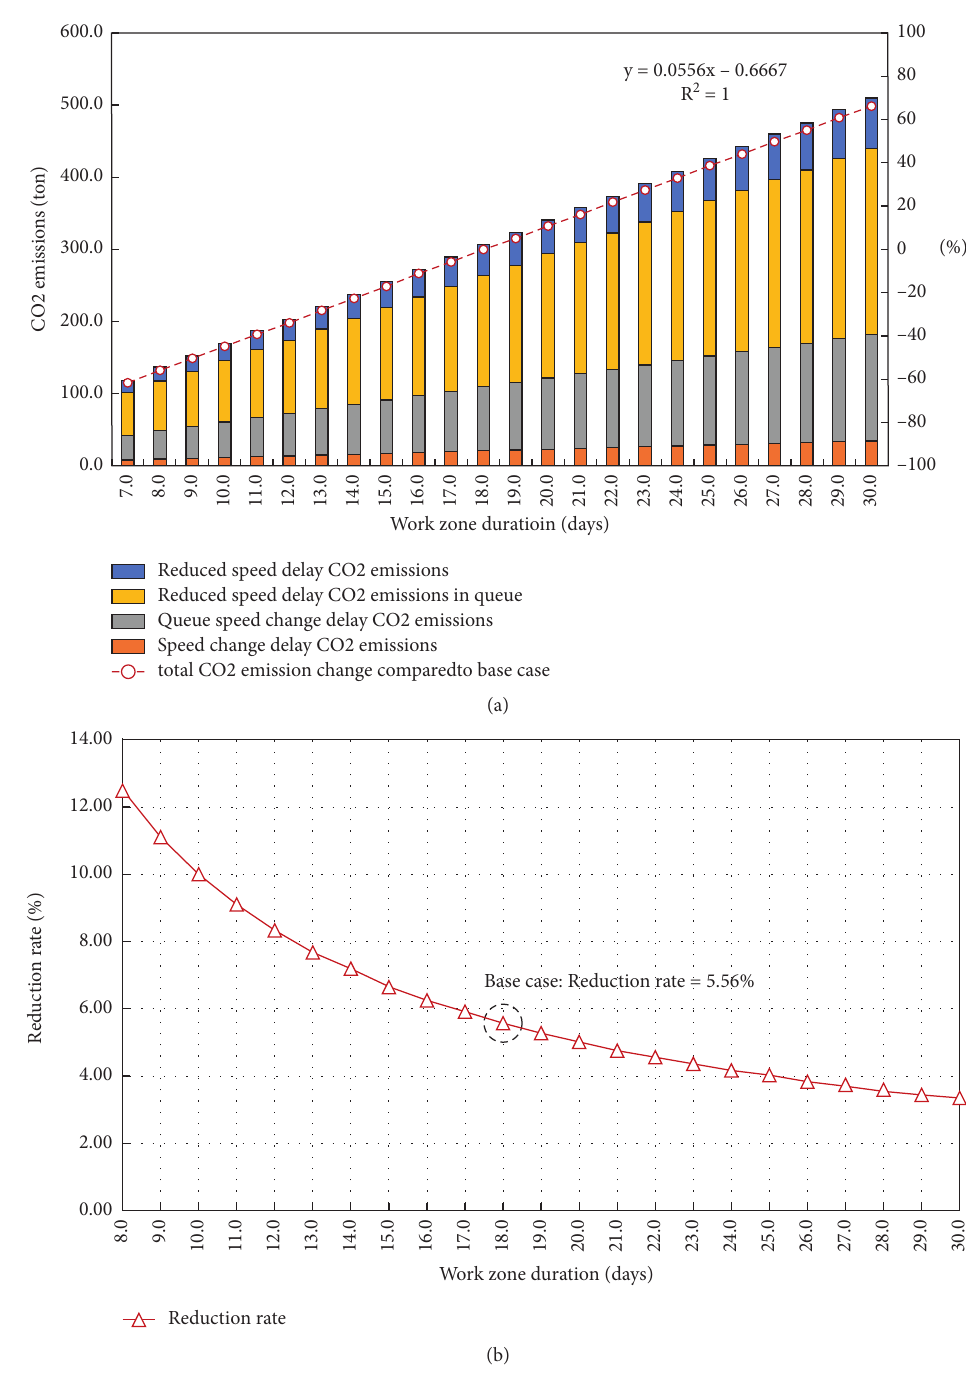
Figure 6: (a) Total work zone user CO 2 emissions and change rate compared to base case for different work zone duration; (b) reduction rate of total work zone user CO 2 emissions per day saving for different initial work zone